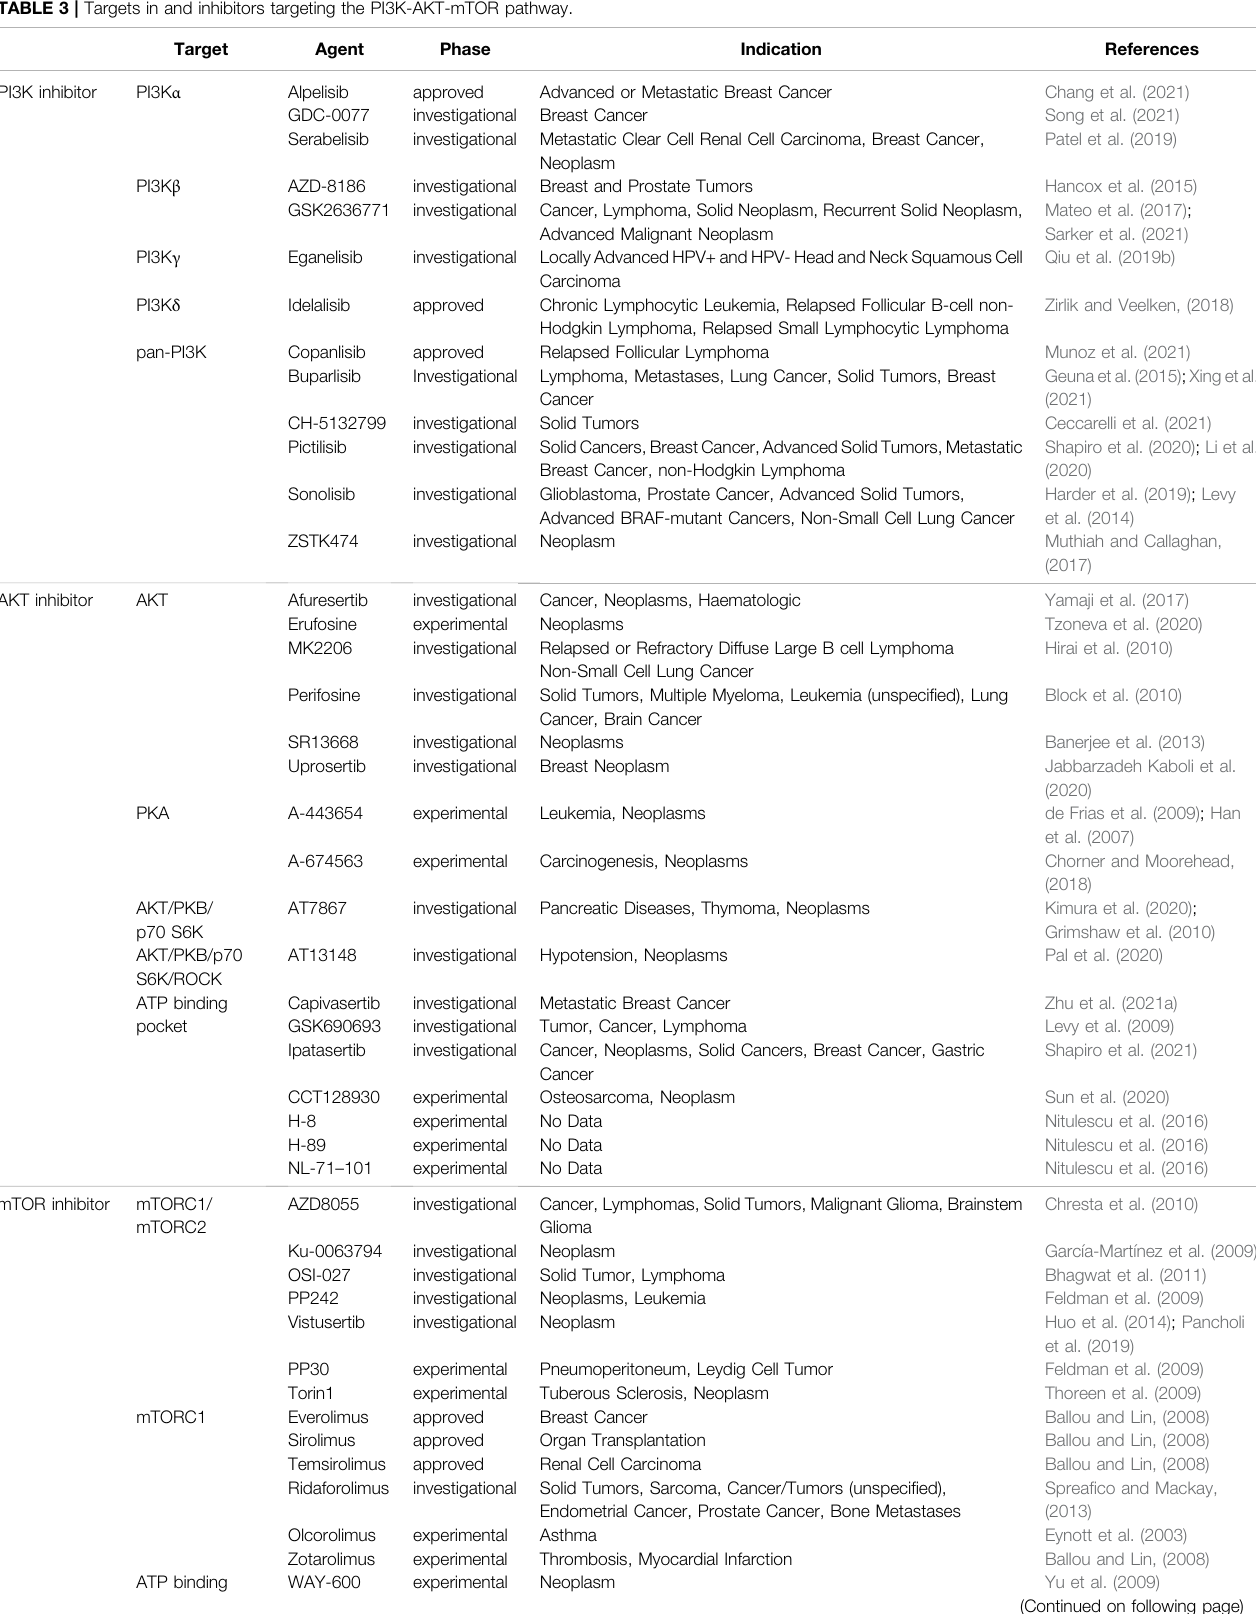
TABLE 3 | Targets in and inhibitors targeting the PI3K-AKT-mTOR